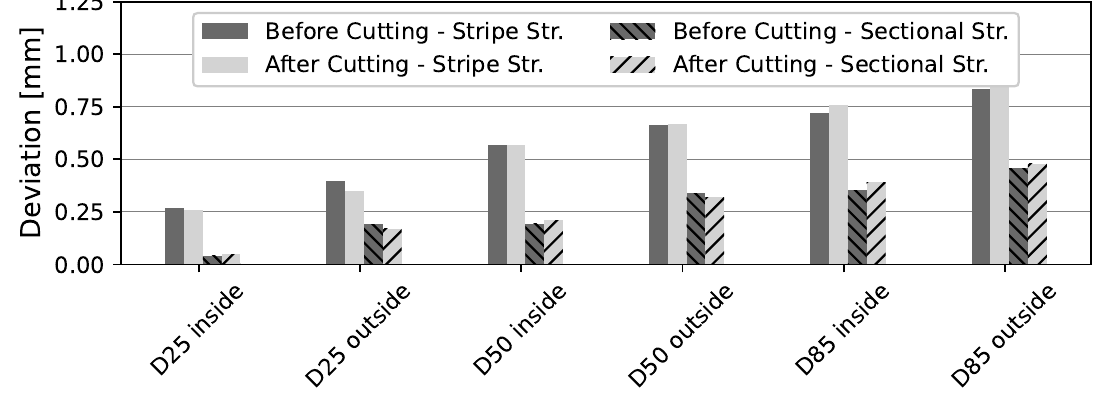
Figure 8. Comparison of maximum deviations for all